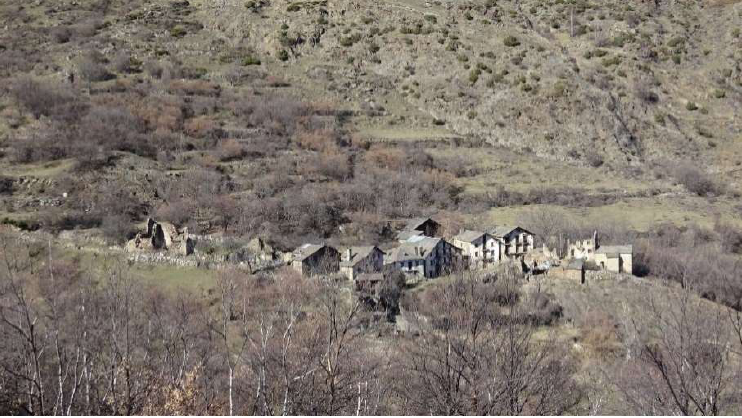
Figure 7. New Àrreu, at present day abandoned (named Àrreu in the official map in Figure 1).